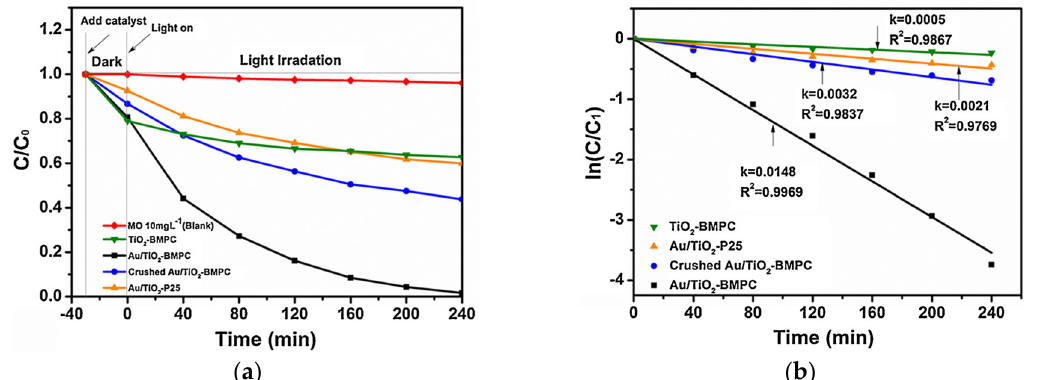
Figure 6. The time course of the photocatalytic degradation of MO under visible-light irradiation ( λ > 420 nm) using bare PCs (TiO 2 -BMPC), Au-modified PCs (Au / TiO 2 -BMPC), crushed Au-modified PCs (Au / TiO 2 -BMPC) and commercial titania modified with Au NPs (Au / TiO 2 -P25): ( a ) a decrease in the concentration of dye during degradation (C / C 0 ), and ( b ) the respective logarithm plots; Reprinted with permission (after formatting) from [120]. Copyright (2016)